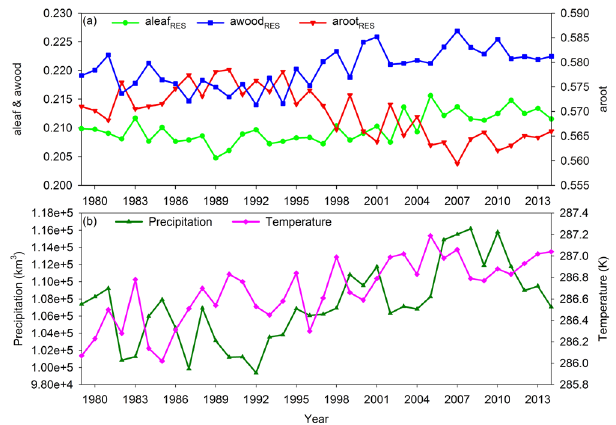
Figure 2. Estimated carbon allocation coefficients ( a ), and precipitation and temperature ( b ) from 1979 to 2014. The global mean annual carbon allocation to leaves (aleaf REF ), wood (awood REF ), and roots (aroot REF ) were simulated by CABLE using the resource limitation (RES) model ( a ). The annual total precipitation and mean temperature of the plant-covered area were calculated from MERRA data ( b ).